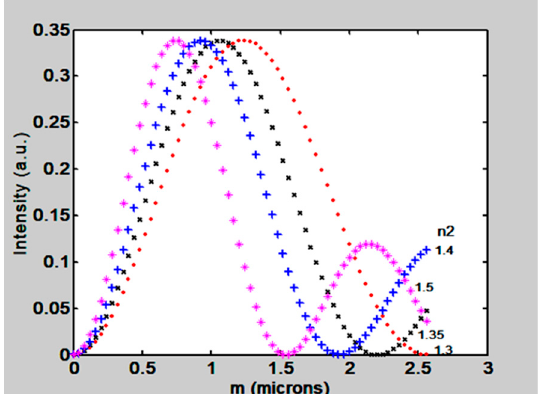
Figure 12. Theoretical behavior of the first order intensity as a function of grating relief modulation m. The refractive index n 2 presented several values.